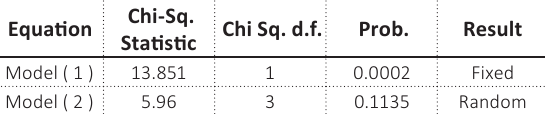
Table 9. Hausman test results